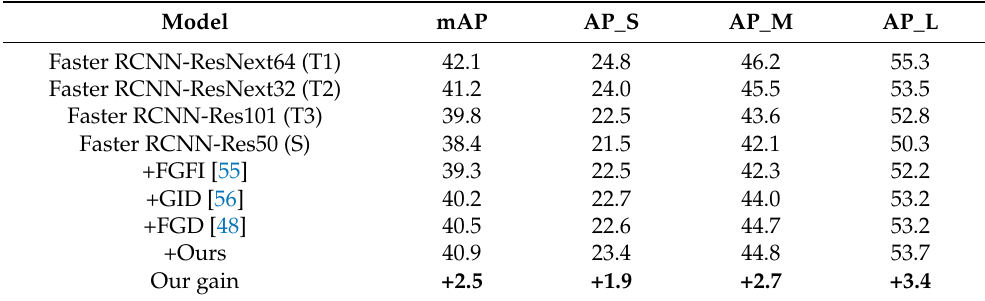
Table 5. Comparison with state-of-the-art distillation approaches on COCO